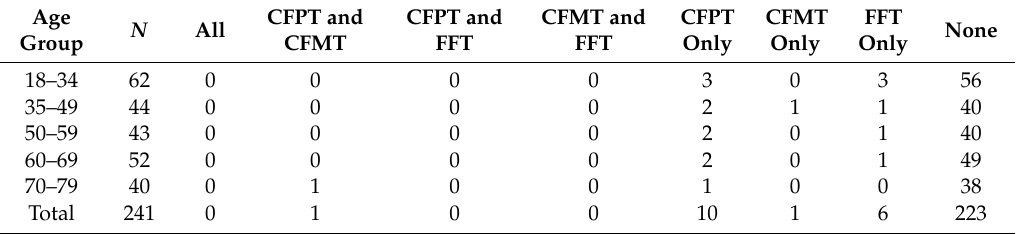
Table 2. Control patterns of impaired performance on the CFPT, CFMT and famous faces test (FFT).